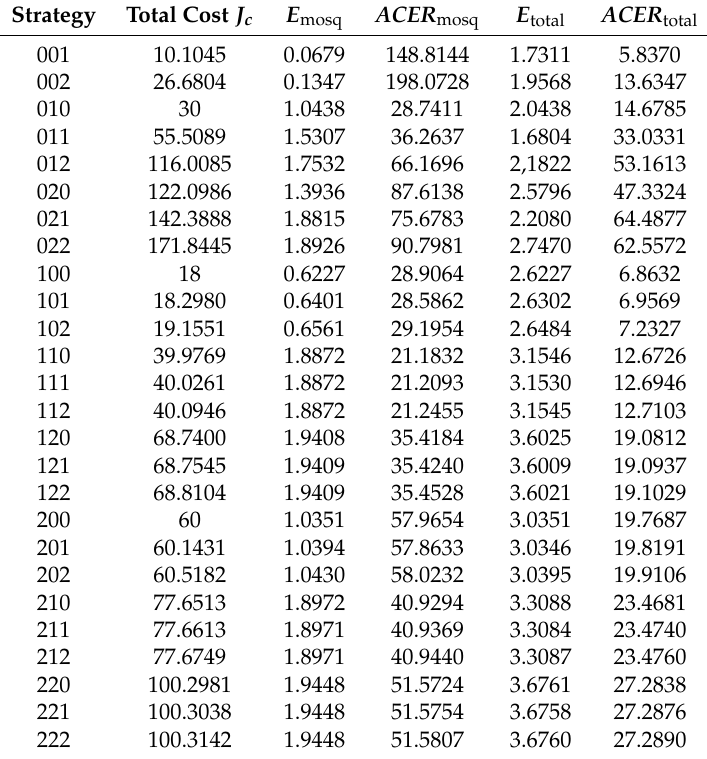
Table 4. Outcomes of ACER evaluation for 27 optimal strategies with two types of effects, E mosq and E total